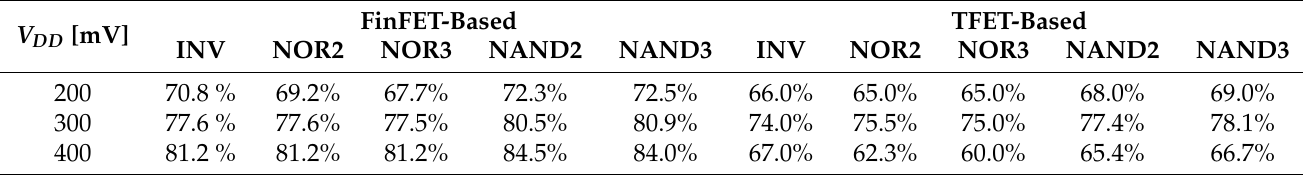
Table 2. Noise margin normalized to 50% of the supply voltage for FinFET and TFET-based INV,